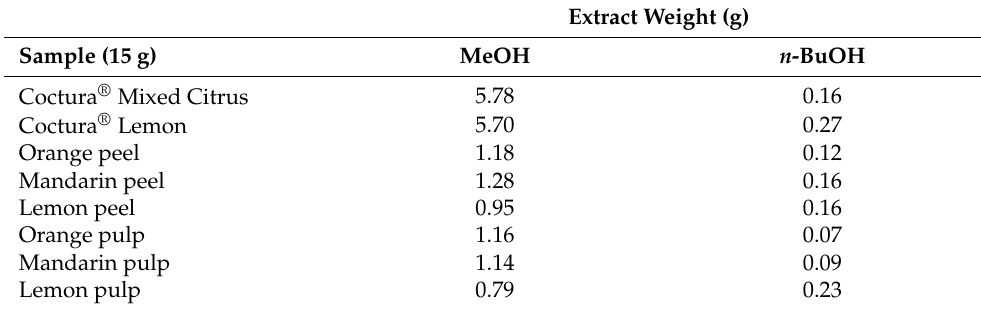
Table 2. Extraction yield of Citrus